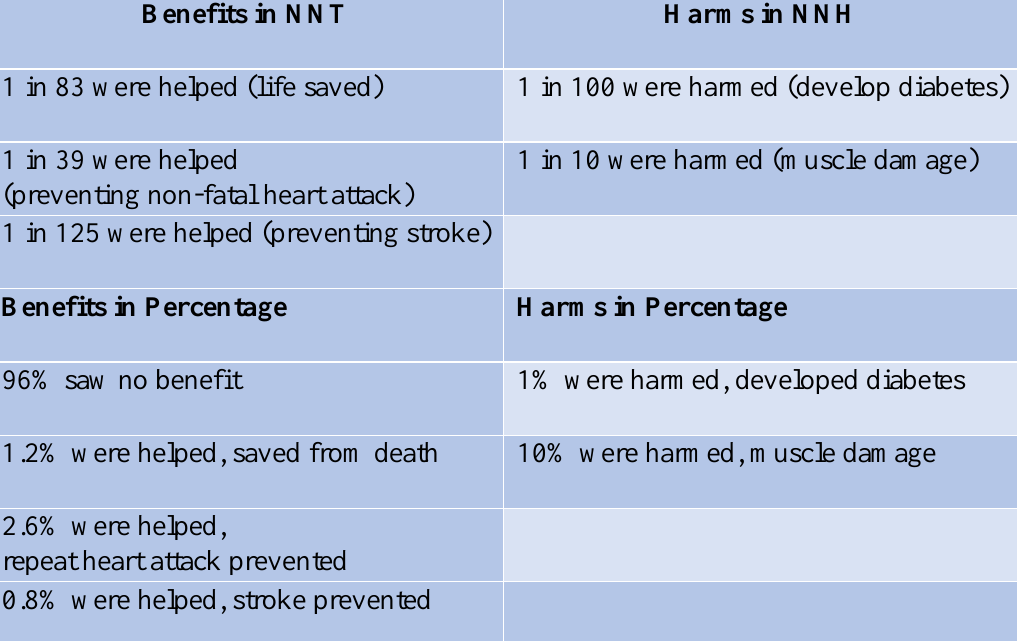
Table 3. Statin treatment of people with heart